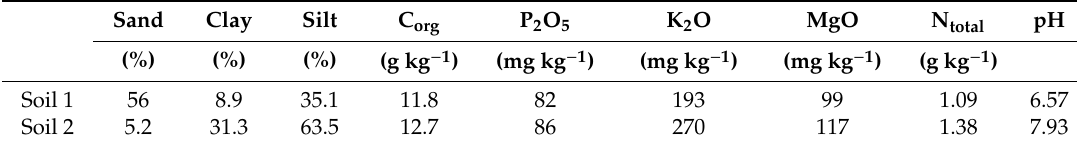
Table 1. Texture and chemical composition of both